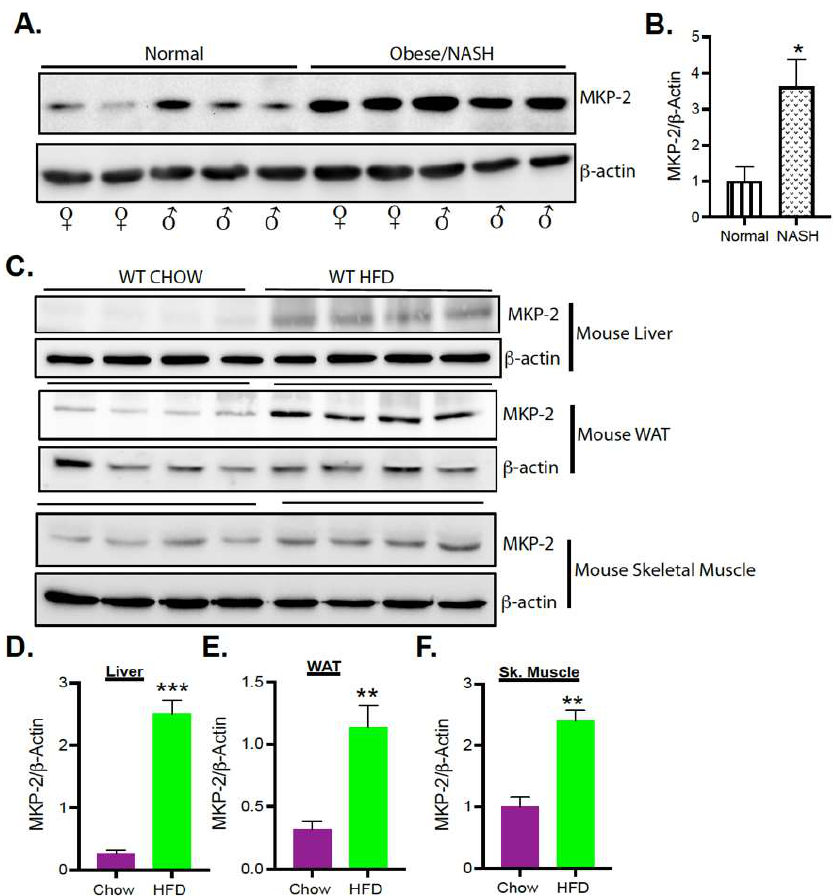
Figure 1. Upregulation of MKP-2 Expression in Human and Mice Livers with Obesity and Fatty Liver Disease. Liver tissue lysates from male and female normal (BMI ~25 kg/m 2 ) and obese NASH (BMI ~30 kg/m 2 ) human subjects (N = 7/group) ( A , B ). Liver, skeletal muscle, and white adipose tissue lysates from wild-type chow and HFD-fed mice (N = 4–6) ( C – F ) were analyzed by immunoblotting. Representative immunoblots were quantitated by densitometry for the levels of MKP-2 and β -actin. Results represent the mean ± SEM; * p < 0.05, ** p < 0.01, *** p < 0.0001 as determined by Student’s t